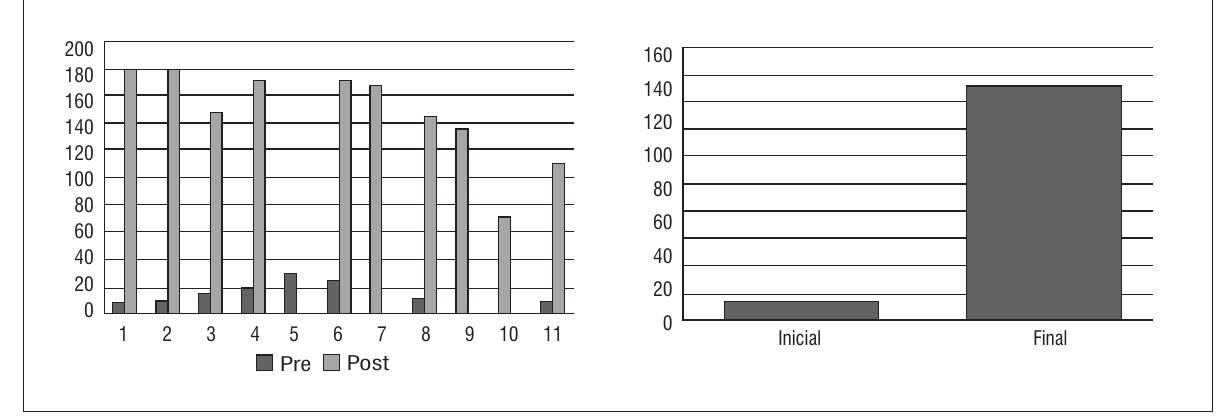
Figure 3 - Evolution of shoulder abduction of motion after surgery. (A) Individual results goniometry before treatment (initial Gonio) and 12 weeks of treatment (final Gonio). (B) Average results of the study group, showing statistically significant in- crease (p < 0.001) range of motion after treatment. Values are shown in degress (°)